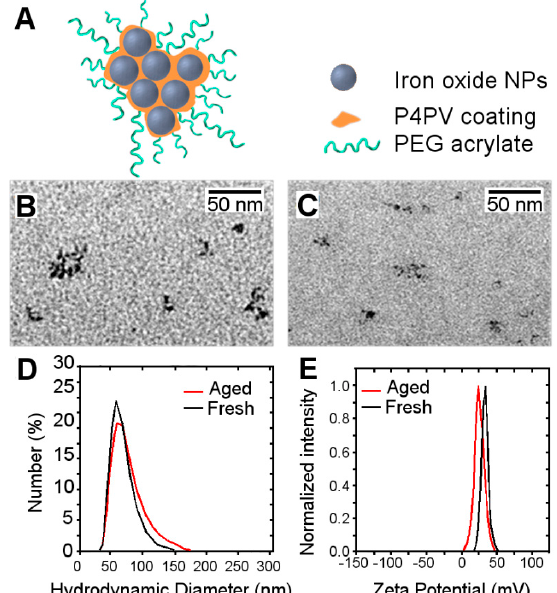
Figure 2. ( A ) Schematic representation of IONPs and their components. Transmission electronic microscopy (TEM) images of freshly prepared IONPs ( B ) compared with aged IONPs ( C ). Hydrodynamic diameter (( D ), in nm) of fresh (black line) vs. aged (grey line) solutions. ( E ) Zeta potential (in mV) of fresh (black line) and aged (grey line) IONPs’